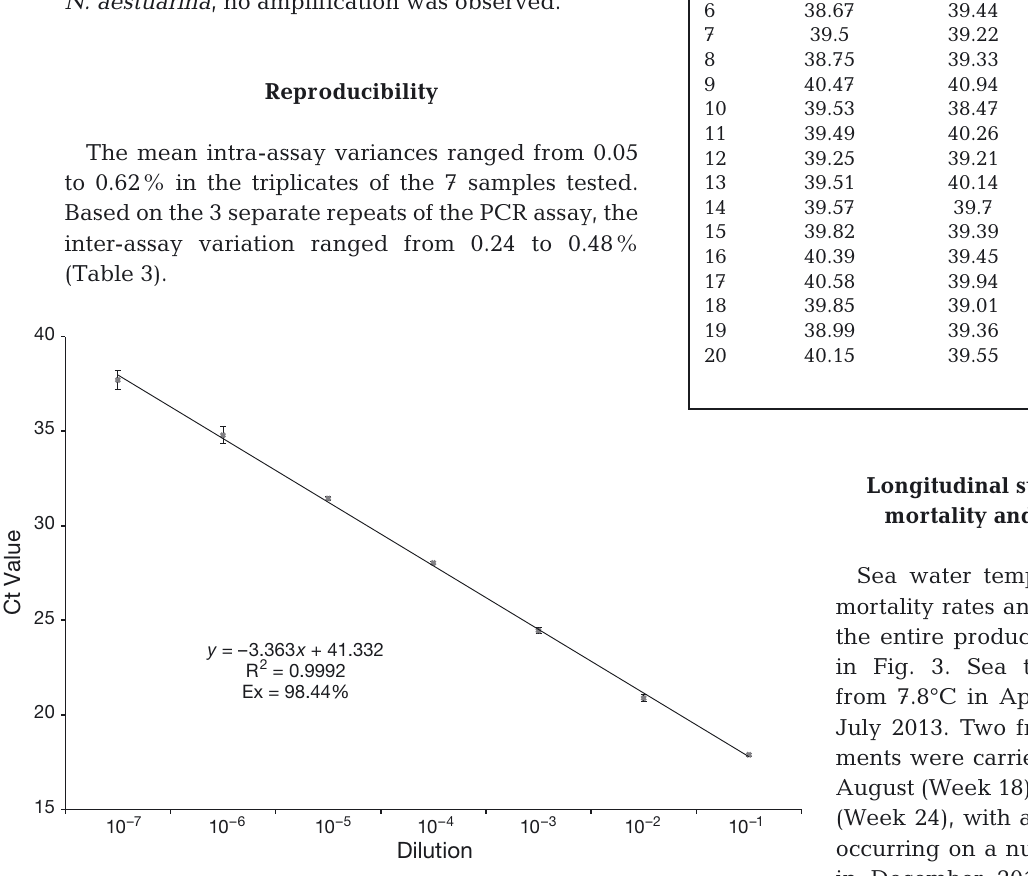
Fig. 2. Amplification of quadruplicate log dilutions of Neoparamoeba perurans plasmid DNA in Atlantic salmon gill samples. At each point, the Ct value was plotted against the dilution. Ex: amplification